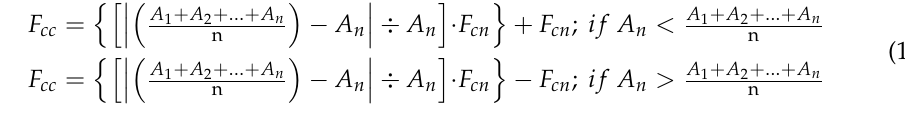
Figure 6. Method of determining the cross-sectional area of the corn stalk in the AutoCad soft- ware.